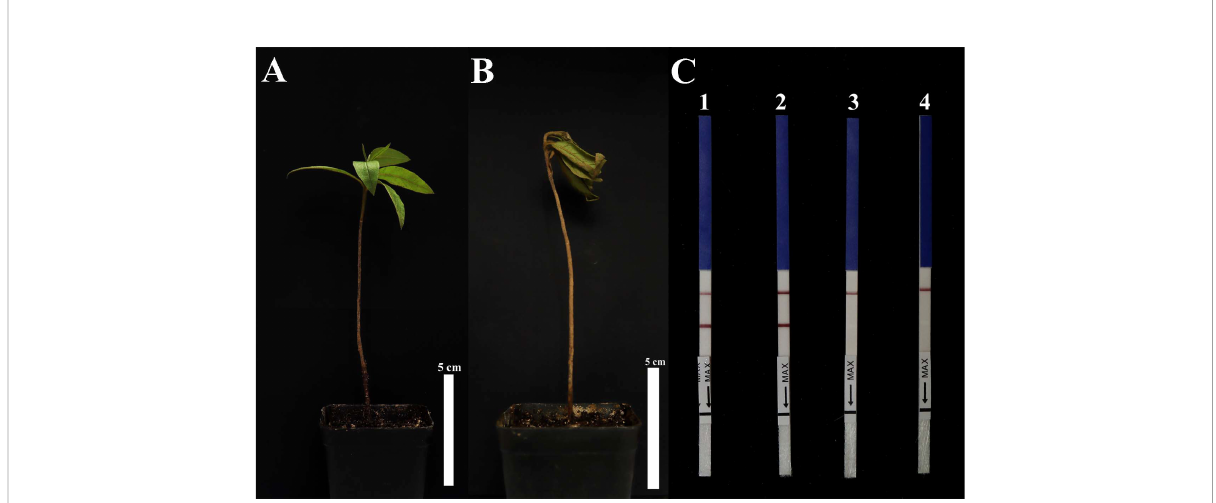
FIGURE 7 Detection of Phytophthora cinnamomi in arti fi cially inoculated soil. (A) R. pulchrum was grown in non-inoculated soil for 10 days. (B) R. pulchrum was grown in arti fi cially inoculated soil for 10 days. (C) Detection of arti fi cially inoculated soil by RPA-LFD assay. 1, positive control. 2, arti fi cially inoculated soil. 3, non-inoculated soil. 4, negative control. Data is representative of three replicate